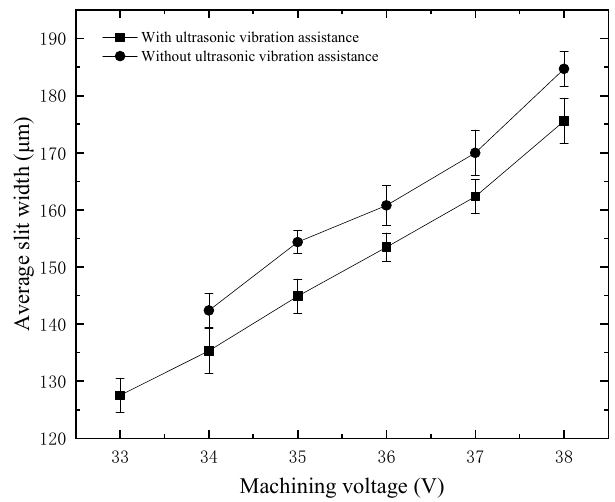
Figure 10. Slit width under different machining voltages.